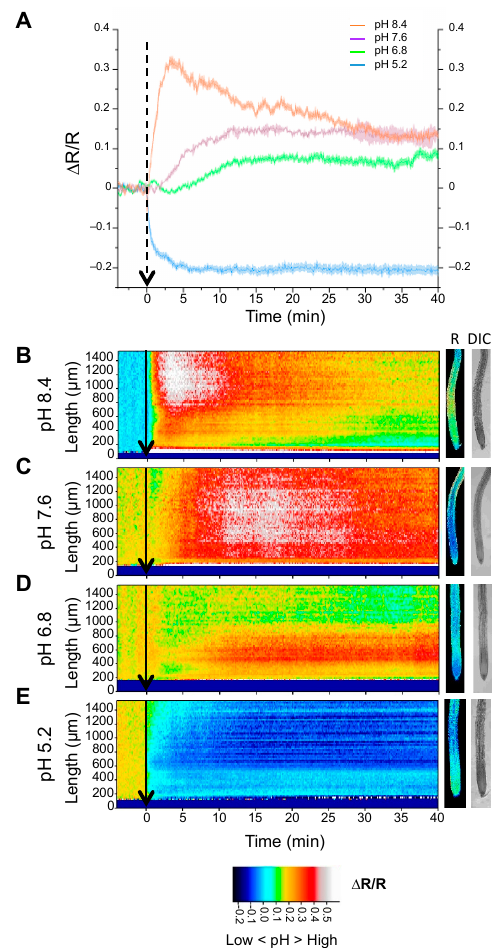
Figure 1. Response of pHGFP-VTI11 to external pH. Measurement of variations in pHcyt sensed by the pHGFP-VTI11 reporter in Arabidopsis thaliana Col-0 seedlings. ( A ) Normalized emission ratio ( ∆ R/R) changes, presented as means ± SEM. Values derive from the quantifications of ∆ R/R in the MEZ zone of at least two independent experiments per treatment. ( B – E ) Heat-maps of normalized fluorescence data derived from 64 adjacent regions (268.2 × 24.2 µ m) according to the length scale shown. Arrows indicate the beginning of the treatment. Pictures on the right show fluorescence emission ratio (R) and bright-field (DIC) images of roots at time point 35 min. Below, frames with false-color calibration bars of the heat map. Heat-maps and root pictures are representative of at least 2 independent experiments for each